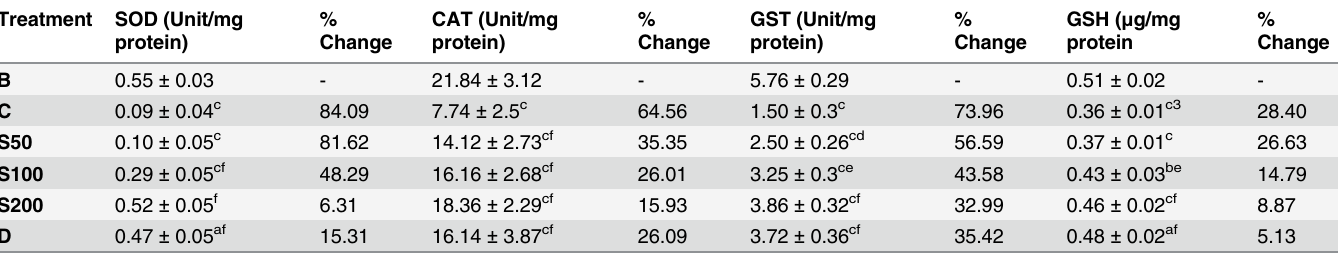
Table 3. The effect of DBME on liver parameters (SOD, CAT, GST, GSH) in iron overloaded mice. Treatment SOD (Unit/mg % protein) Change